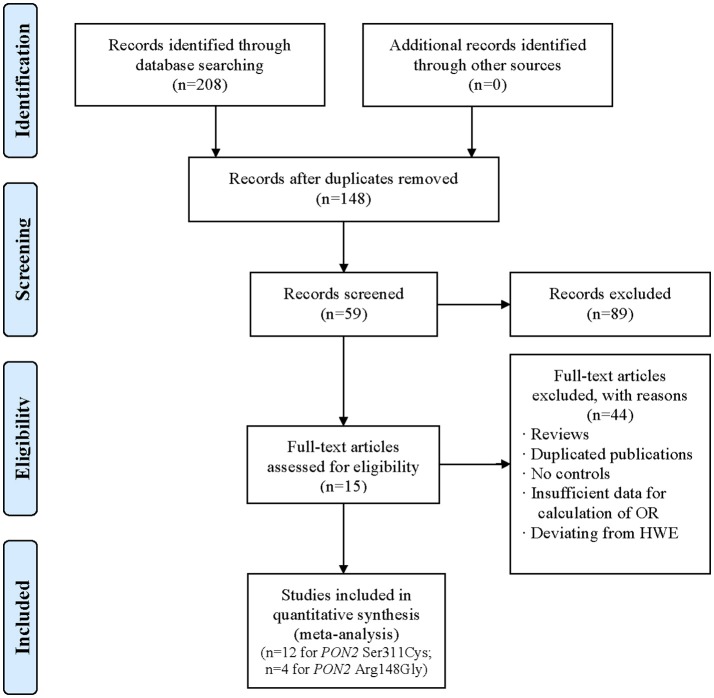
Flow diagram of the selection process of research studies The terms “n” in the boxes represent the number of corresponding studies.